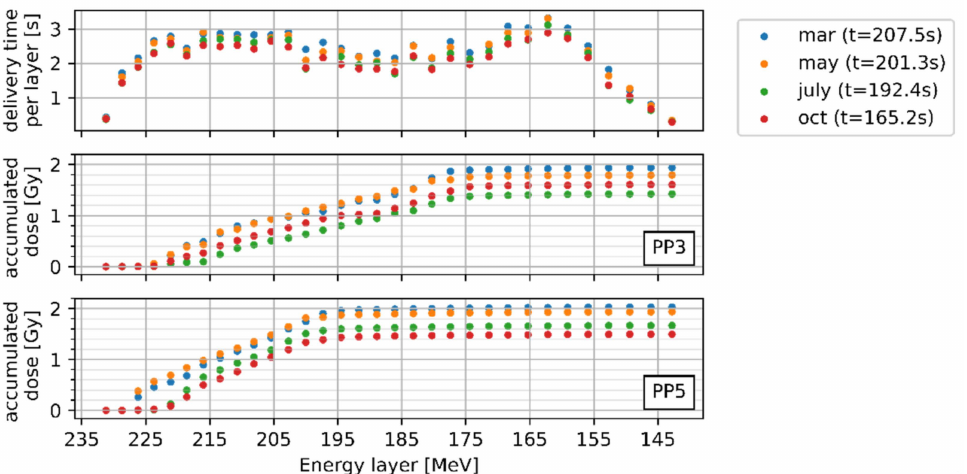
Figure 4. Delivery time per energy layer and dose for PP3 and PP5 for the different energy layers on four measurement days; static dose values were: PP3 = 1.97 ± 0.01 Gy and PP5 = 1.85 ± 0.01 Gy; t gives the total delivery time of each measurement day varying between 165.2 s to 207.5 s.